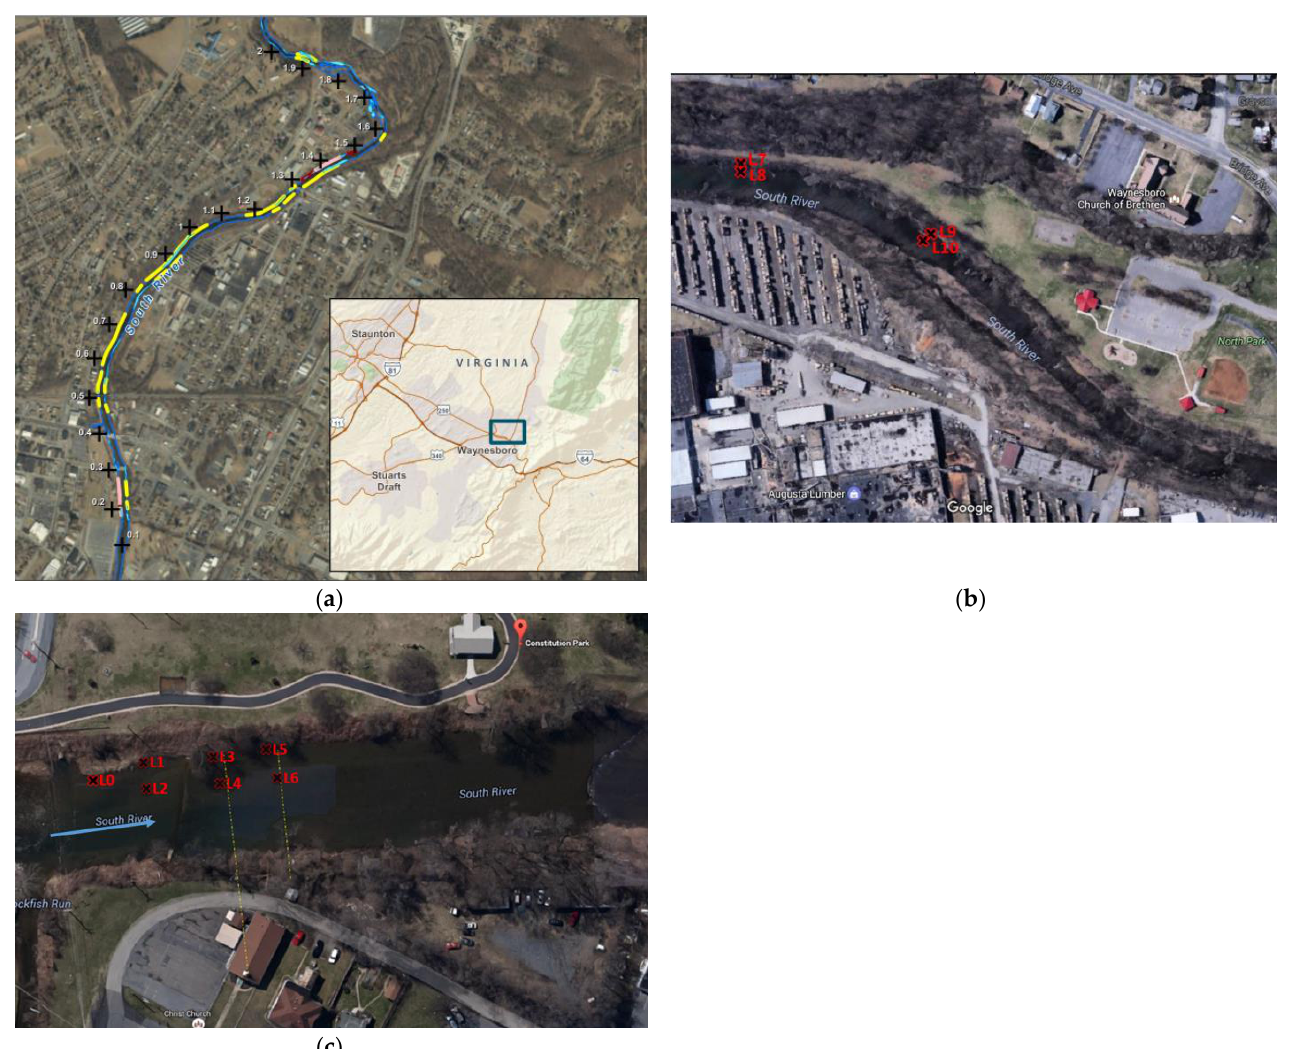
Figure 2. The area of study: ( a ) South River, near Waynesboro, VA; ( b ) Constitution Park and the sampling locations in bank (L0, L1, L3, L5), and channel (L2, L4, L6) that were used for sampling (2015 – 2020); ( c ) North Park and the sampling locations in riverbank (L7 and L9) and channel (L8 and L10) that were used for sampling in 2015.